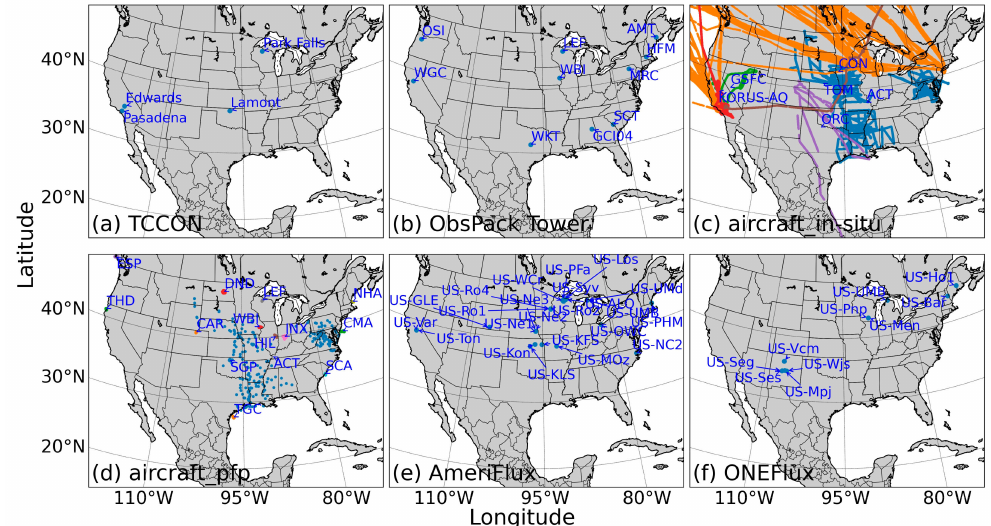
Figure 1. The WRF-Chem domain and locations of ground-based and aircraft observations for evaluation. ( a ) TCCON, ( b ) towers, ( c ) aircraft with in-situ measurements, ( d ) aircraft with Programmable Flask Package (PFP) measurements, ( e ) Eddy covariance measurement stations from AmeriFlux network, ( f ) Eddy covariance measurement stations from ONEFlux (Open Network-Enabled Flux processing